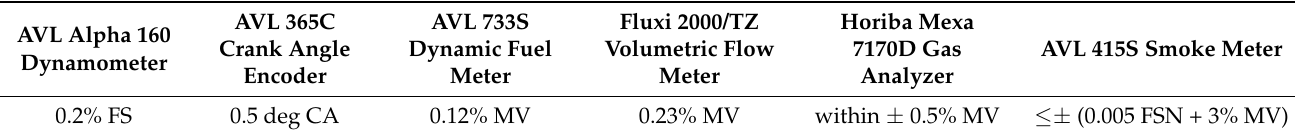
Table 2. Measuring accuracy for each device of the main equipment used.